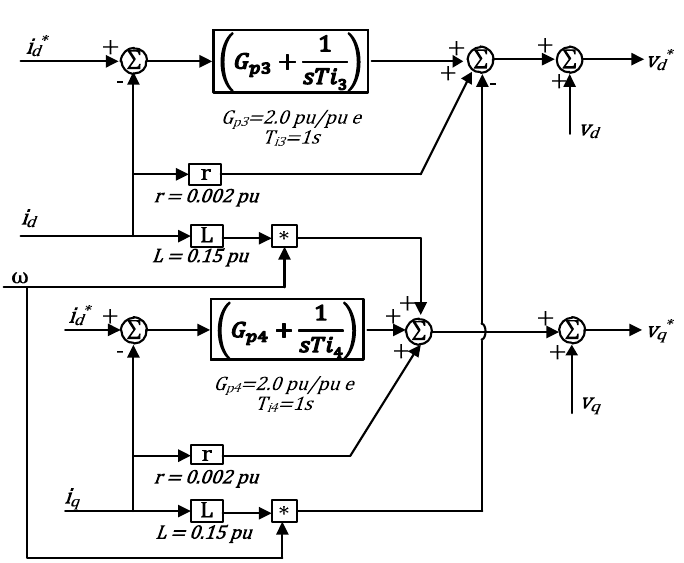
Figure 9. Inner current controller block diagram for FBMMC1 and FBMMC2.